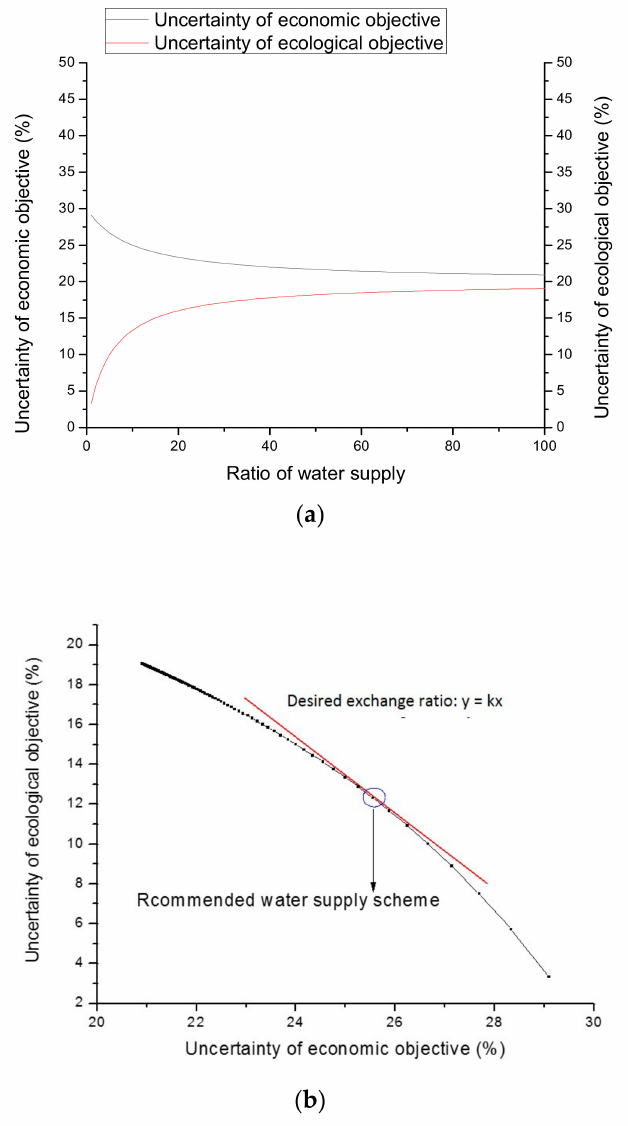
Figure 3. Determination of the recommended water supply. ( a ) Variety of the objective uncertainty under different water supply ratio. ( b ) Scheme optimization based on the expected exchange ratio